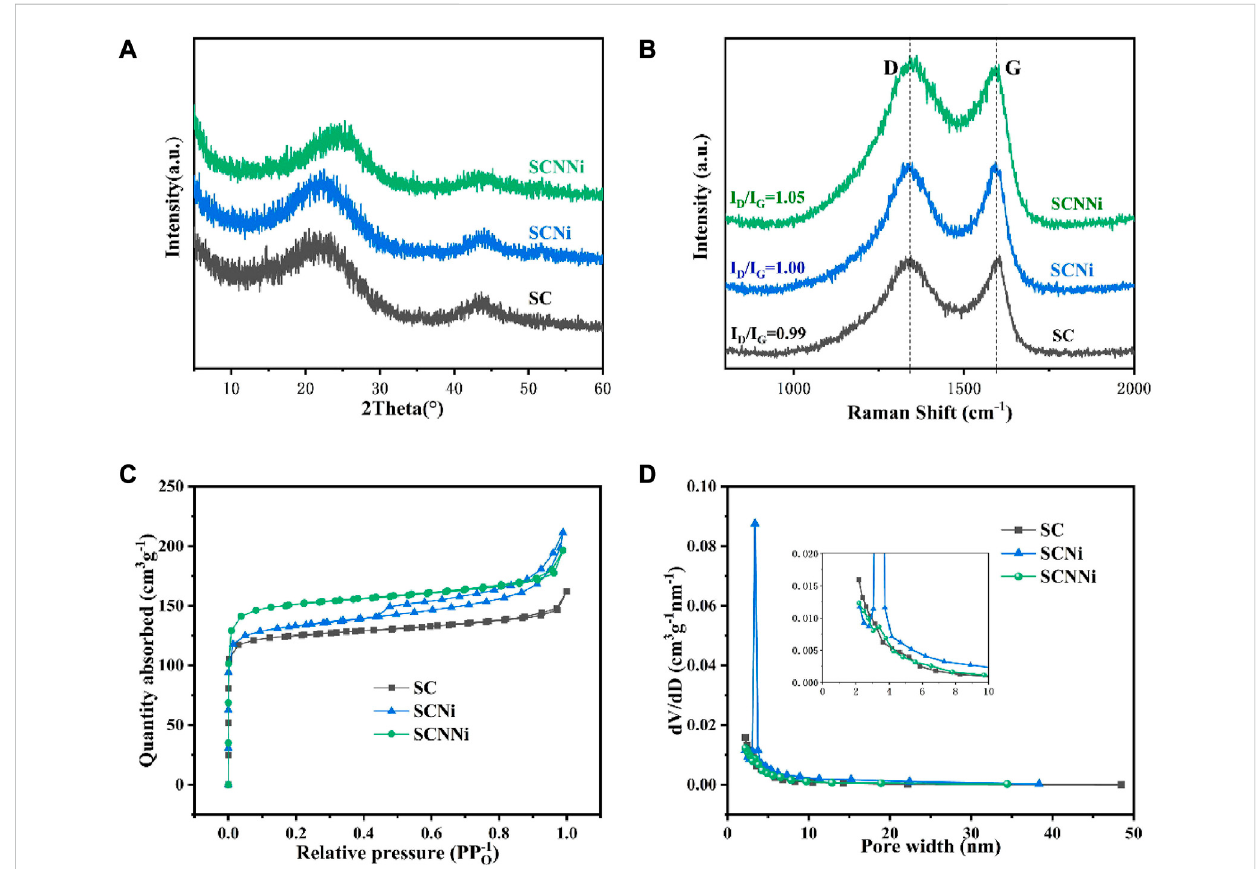
FIGURE 7 (A) XRD patterns and (B) Raman spectra of SC, SCNi, and SCNNi. (C) Nitrogen adsorption – desorption isotherms. (D) Pore size distributions of SC, SCNi, and SCNNi (Qijiu, et al.,